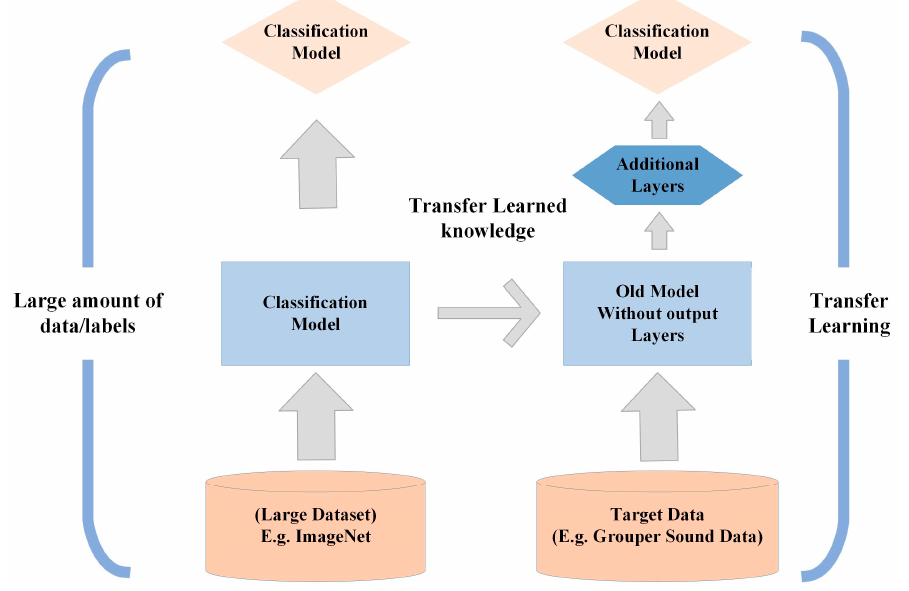
Figure 9. Illustration of transfer learning.